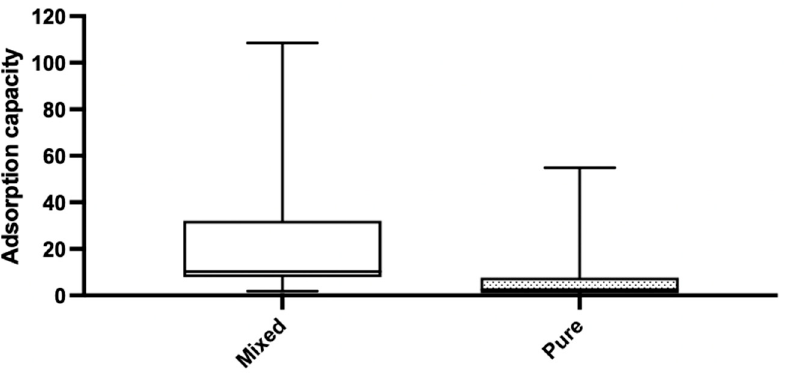
Figure 2. Adsorption capacities of different materials. Table 2. Data availability for influencing factors.